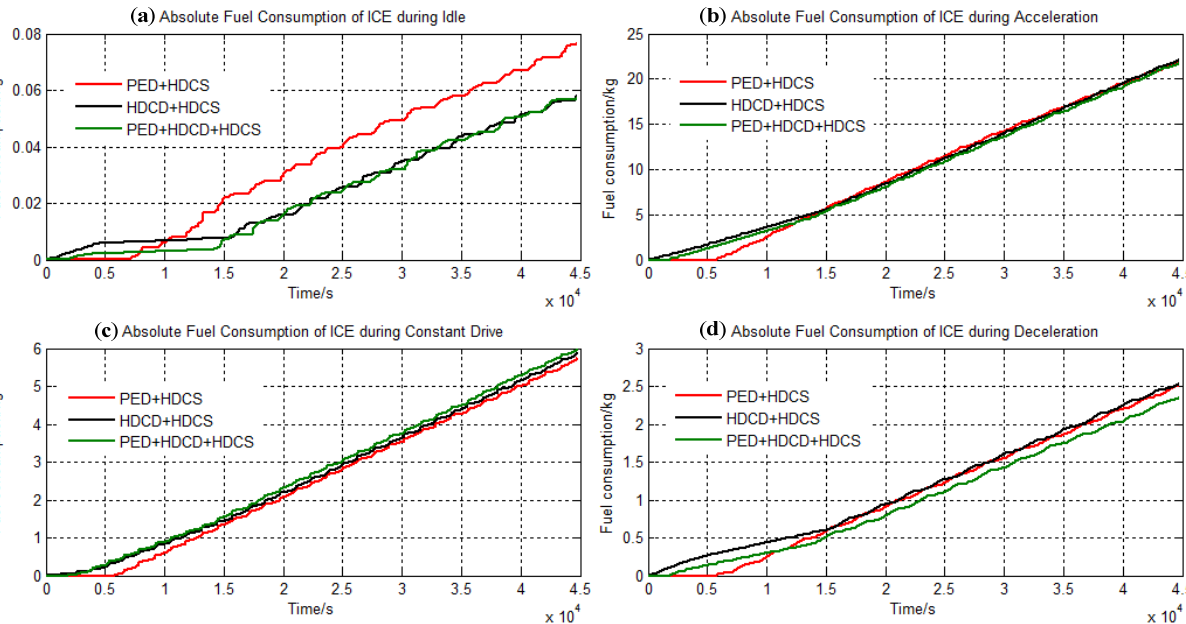
Figure 18. The ICE fuel consumption curves during different working conditions under different